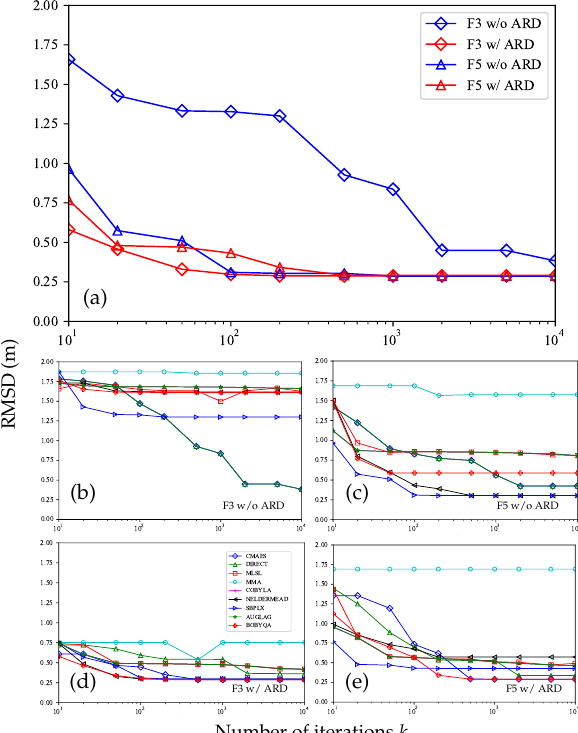
Figure 11. RMSDs with different numbers of iterations on F3 and F5. The best RMSDs among all the DFO solvers and the individual RMSDs are shown in ( a ) and the group of ( b – e ),